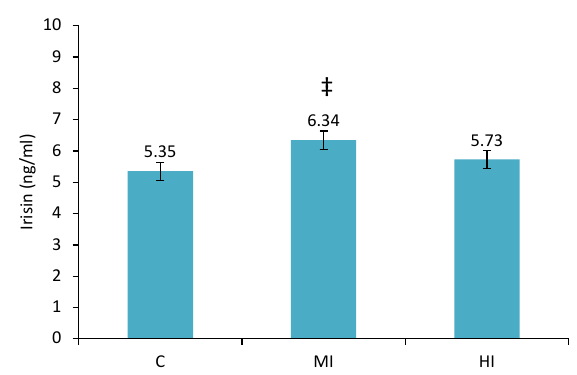
Figure 2. Changes of Irisin levels in different groups. Values are expressed as M±SD. MI: continuous moderate exercise, HI: high- intensity aerobic exercise, C: control. * P <0.05 vs. baseline.